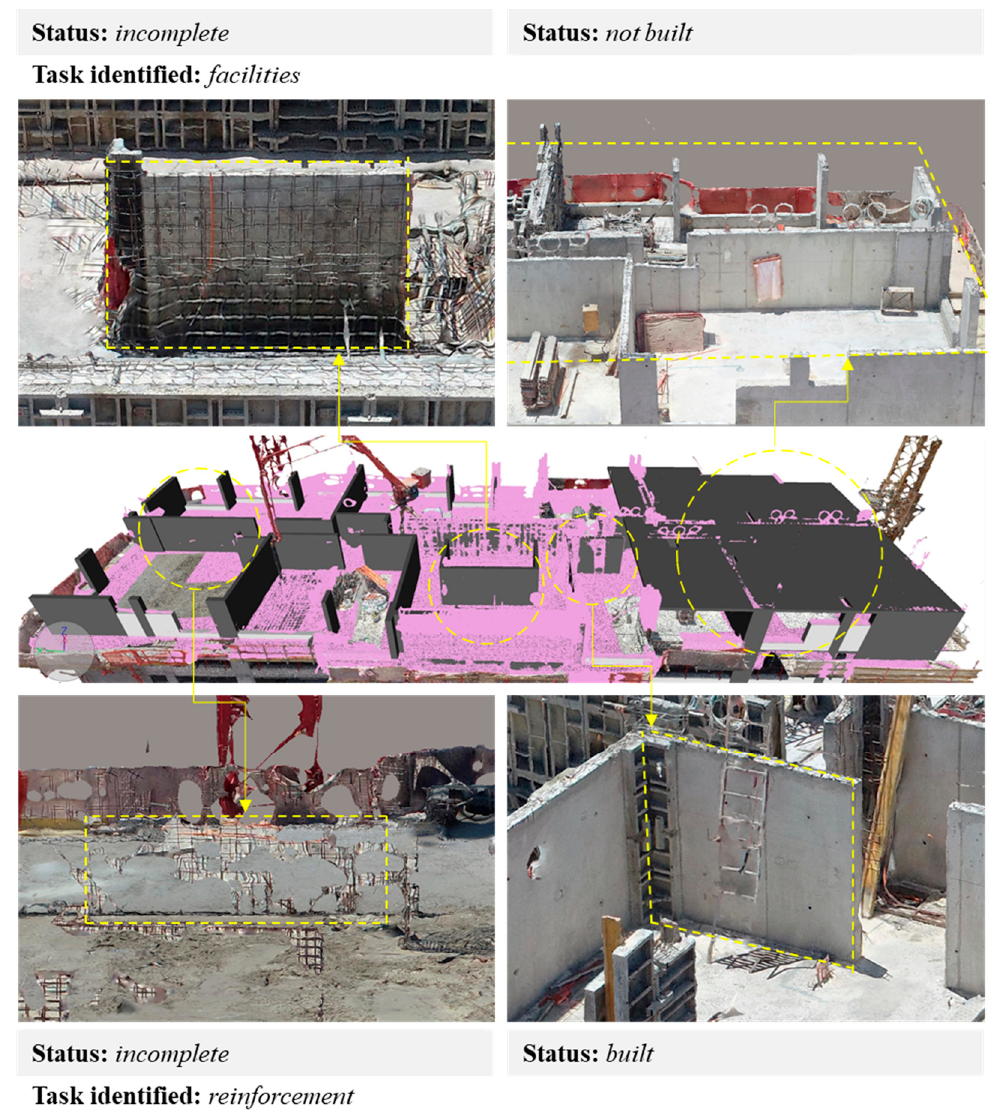
Figure 9. Identification and verification of construction conditions.